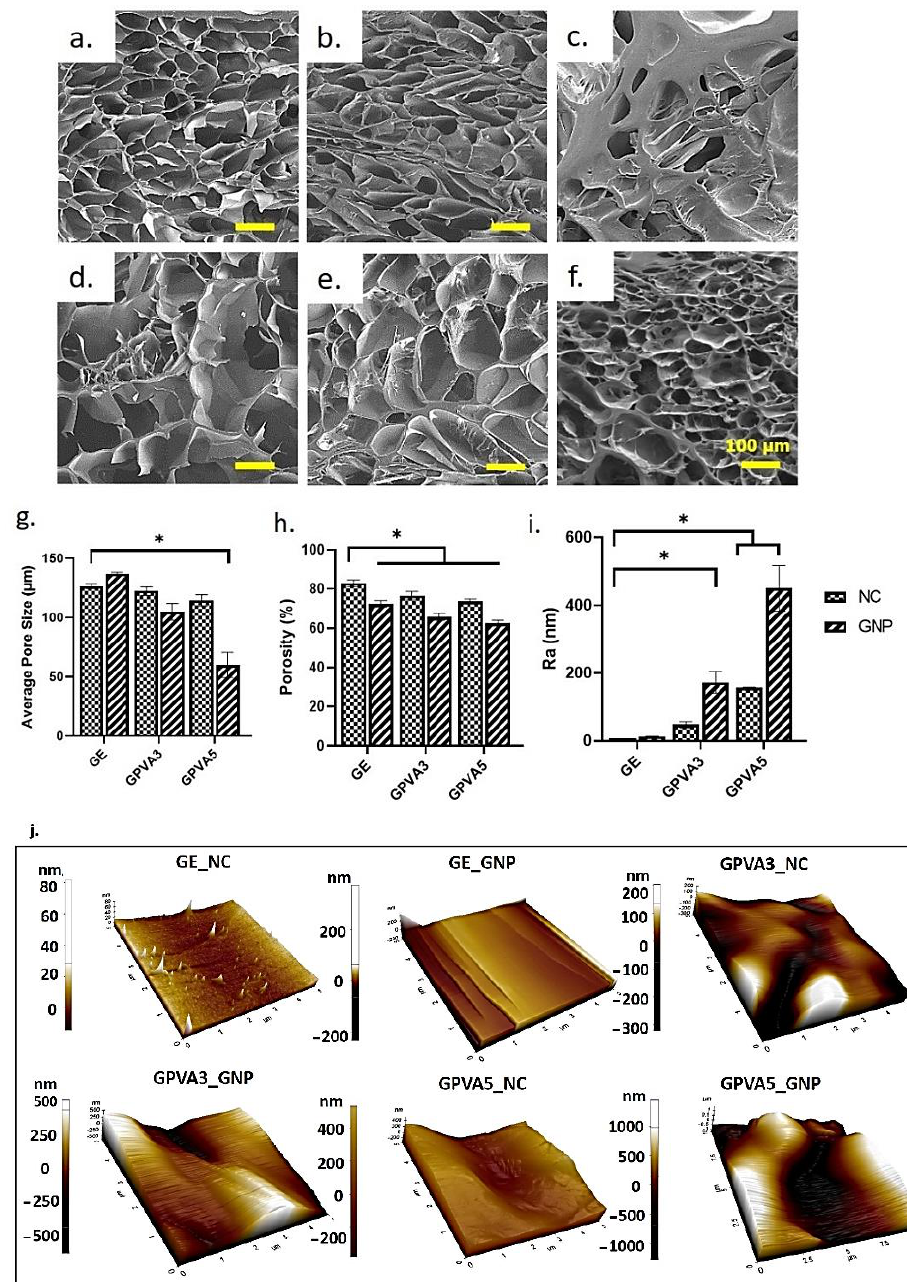
Figure 6. SEM images showing the cross-sectional microporous structure of the hydrogels: ( a ) GE_NC, ( b ) GPVA3_NC, ( c ) GPVA5_NC, ( d ) GE_GNP, ( e ) GPVA3_GNP, and ( f ) GPVA5_GNP under 100× magnification; ( g ) average pore size (μm ); ( h ) porosity percentage; ( i , j ) AFM analysis for surface roughness. * Indicates significant difference.